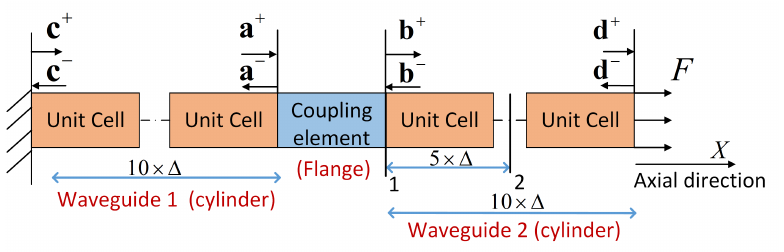
Figure 4. Forced response analysis model in WFEM and FEM. The left boundary is clamped, and a force of 100 N and 132 kHz is applied at the right boundary. The axial displacements of cross-profiles 1 and 2 are extracted and illustrated in Figure 6.